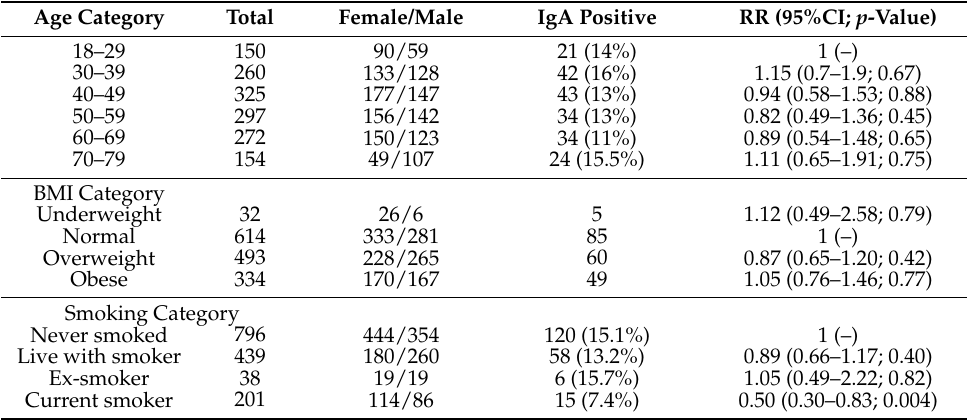
Table 1. Categorical breakdowns of key demographic